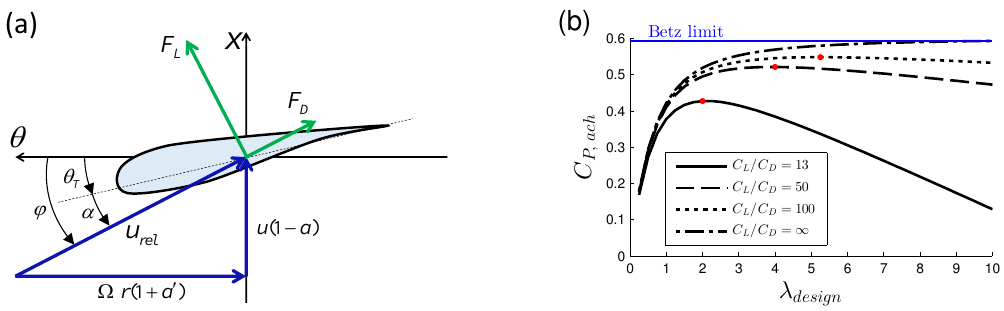
Figure 2. ( a ) The velocity triangle for a rotor blade element; ( b ) Achievable power coefficient C P , ach as a function of the design tip-speed ratio λ design for different values of C L / C D . The maximum achievable power for each C L / C D is shown with a red